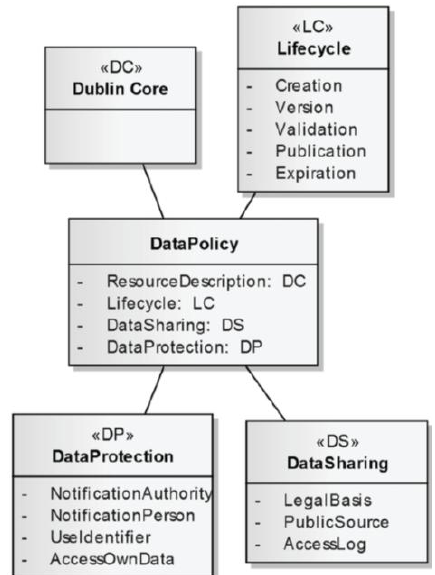
Figure 5. Public data access policy